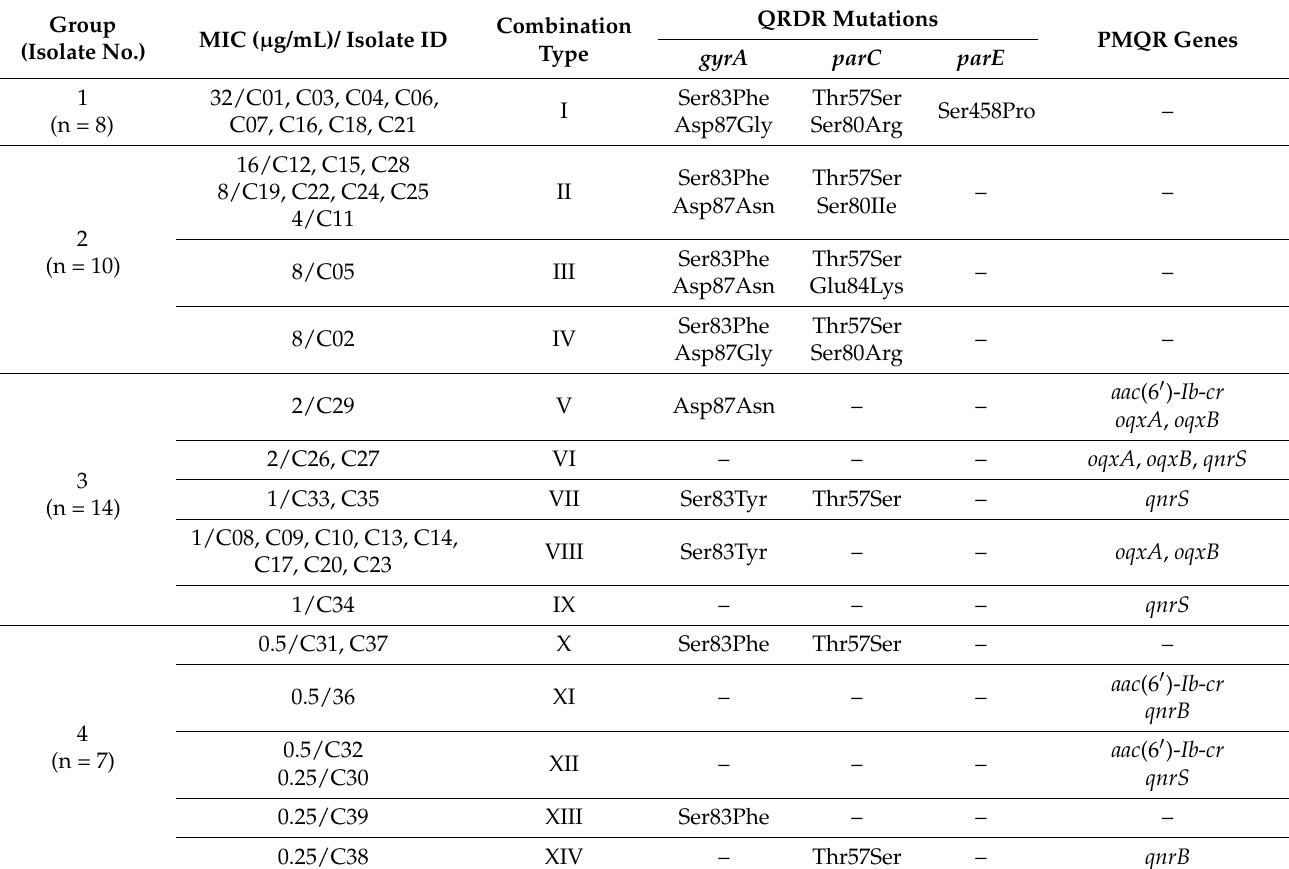
Table 2. Grouping of the ciprofloxacin nonsusceptibility profiles according to MICs and combination types of QRDR mutations and PMQR genes in the 39 NTS